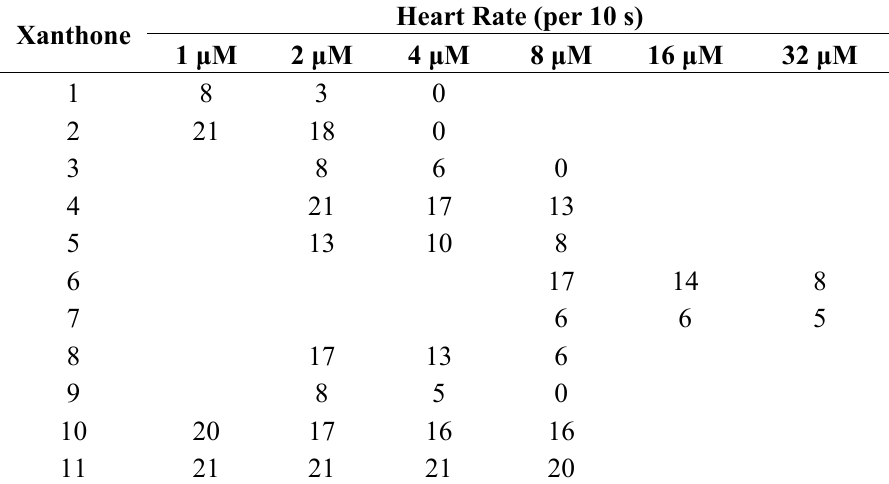
Table 4. Heart rates of caged polyprenylated xanthones 1 – 11 in zebrafish embryos. Zebrafish embryos treated with embryo water were used as control and showed the heart rate: 21 per 10 s. The results shown are representative of three independent